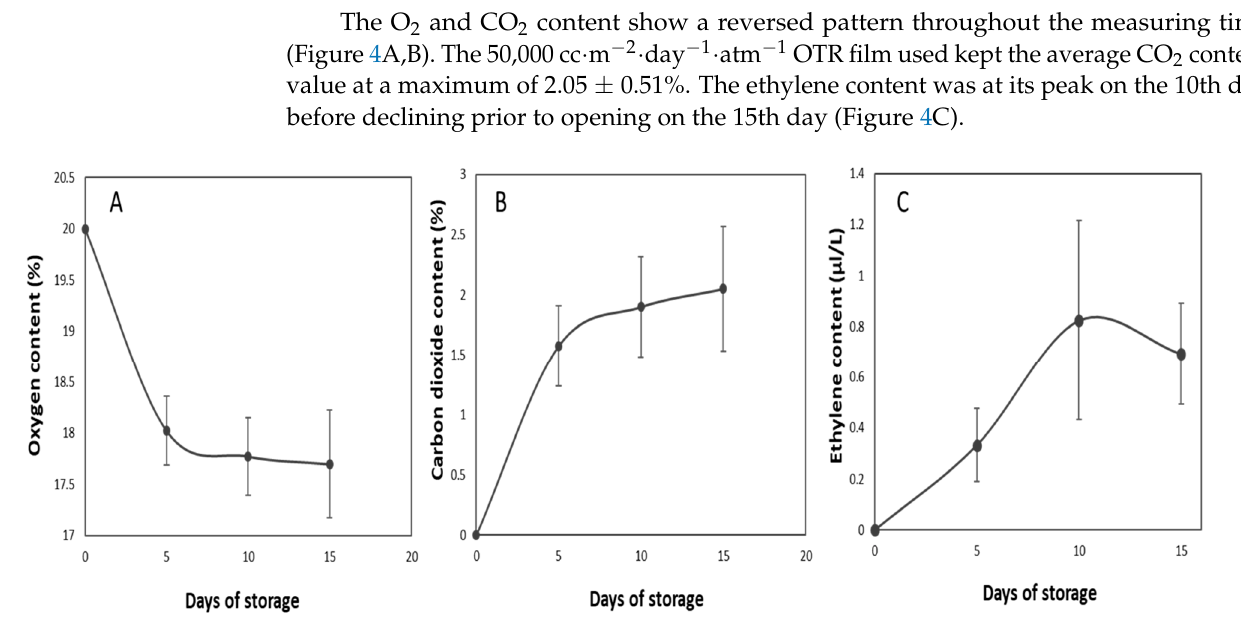
Figure 4. Changes in oxygen ( A ), carbon dioxide ( B ), and ethylene ( C ) content in modified atmosphere packaging (MAP) with 50,000 cc ∙ m − 2 ∙ day − 1 ∙ atm − 1 OTR film MAP throughout cold storage. The vertical bars represent ± SE of n = 4.